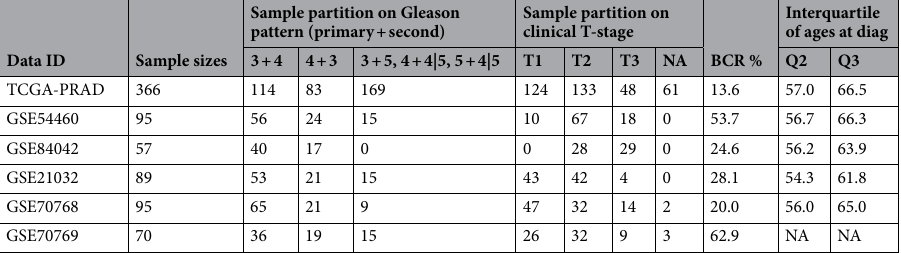
Table 1. Summary of the used datasets regarding clinicopathologic characteristics of